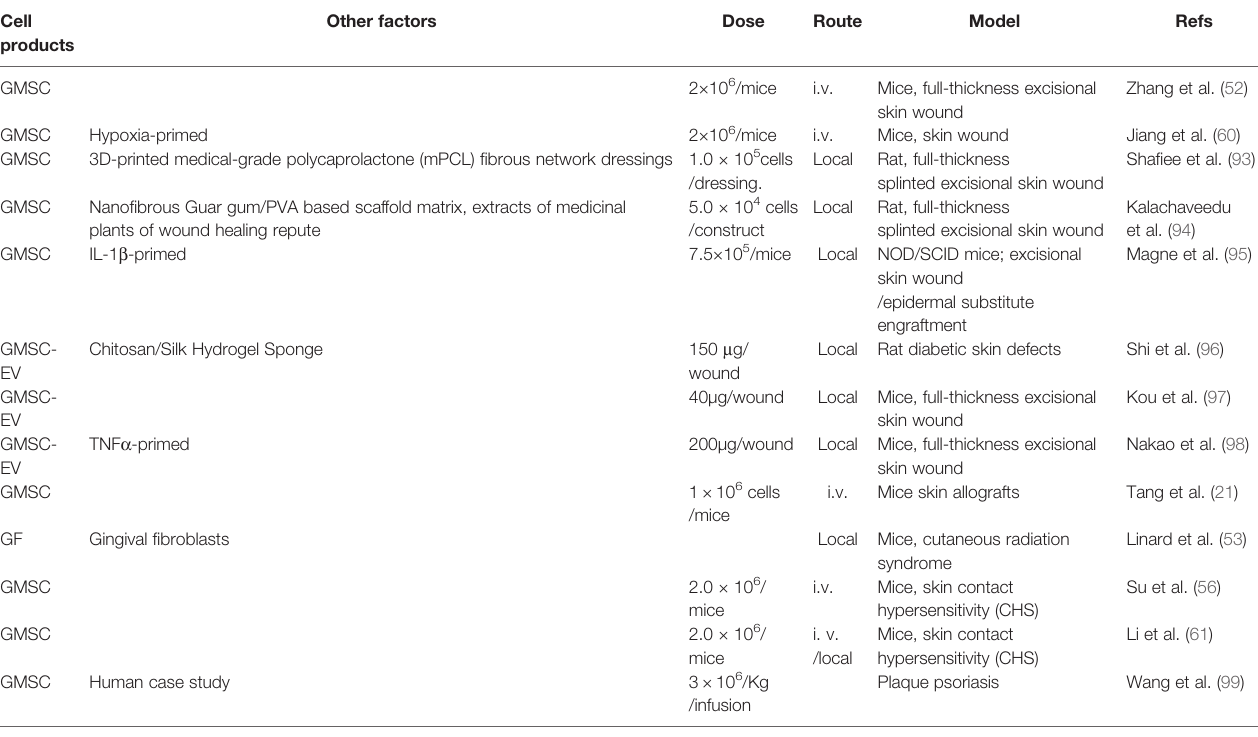
TABLE 3 | GMSC-based regenerative therapy of skin disorders. Cell